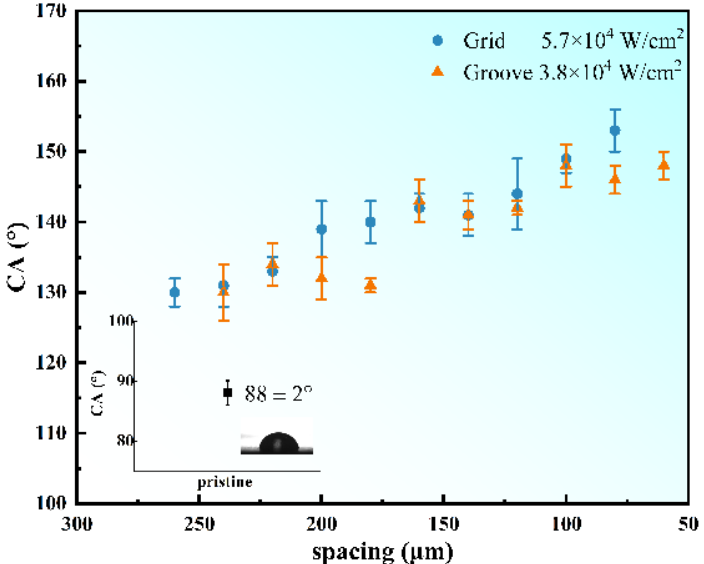
Figure 4. The static contact angles of grid (5.7 × 10 4 W/cm 2 ) and groove (7.6 × 10 4 W/cm 2 ) with spacing from 60 to 260 μ m, the inset is the contact angle value and the photograph of pristine CFRP surface.